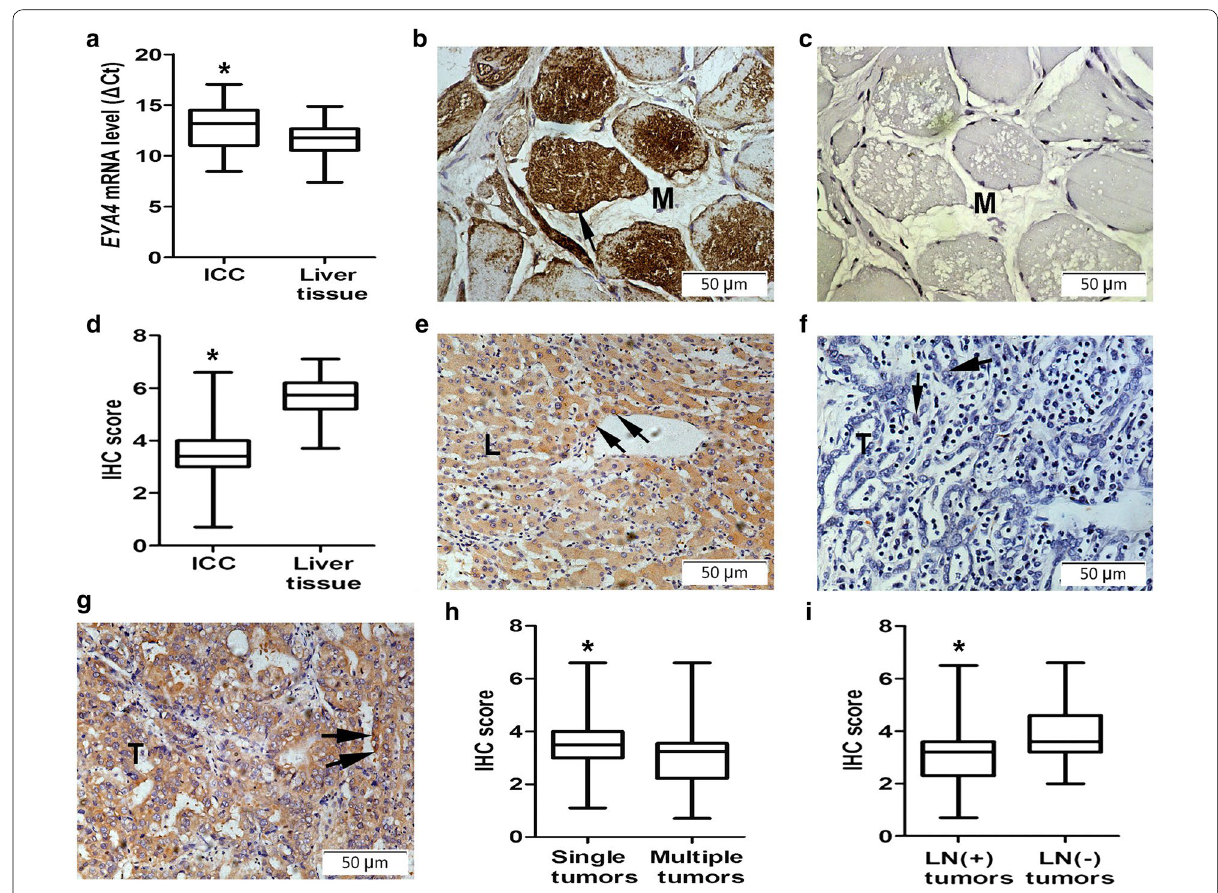
Fig. 1 Eyes absent homolog 4 ( EYA4) mRNA and protein expression in intrahepatic cholangiocarcinoma (ICC) tissues. a Boxplot of EYA4 real‑time quantitative polymerase chain reaction shows that ICC tissues have lower EYA4 mRNA levels than non‑tumorous adjacent liver tissues (* P < 0.001). ΔCt stands for difference in cycle threshold; it was calculated as follows: ΔCt Ct Target gene Ct GAPDH . b Positive control staining of human skeleton = − muscle tissue using EYA4 antibody. c Negative control staining of human skeleton muscle using rabbit IgG as the primary antibody. d Boxplot of EYA4 immunohistochemical (IHC) scores shows that ICC tissues have lower EYA4 protein level than non‑tumorous adjacent liver tissues (* P < 0.001). e A typical staining of adjacent non‑tumorous liver tissue. f A weak staining in tumor tissues with lymph node metastasis. g A strong staining in tumor tissues without lymph node metastasis. Black arrows indicate positive staining of hepatocytes and ICC cells. L liver. T tumor. M muscle. h Boxplot of EYA4 IHC scores shows that multiple tumors have lower EYA4 protein levels than single tumors (* P 0.023). i Boxplot of EYA4 IHC scores = shows that tumor with lymph node metastasis have lower EYA4 protein levels than those without lymph node metastasis (* P <